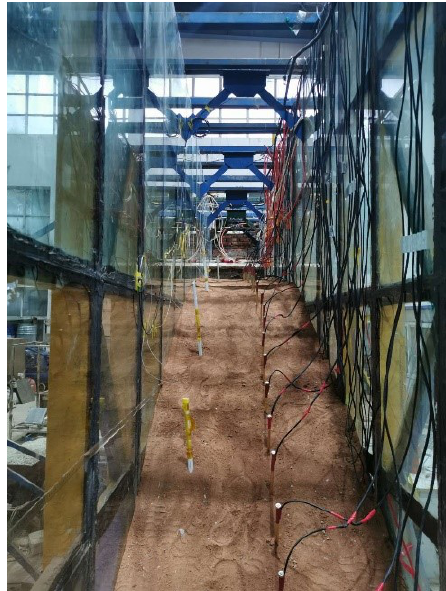
Figure 4. A picture of the landslide model built indoors, from a frontal view: the model was 1.5 m (height) 0.8 m (width). The water content sensor is inside the landslide body (not visible; the actual ∗ water content sensor is shown in Figure